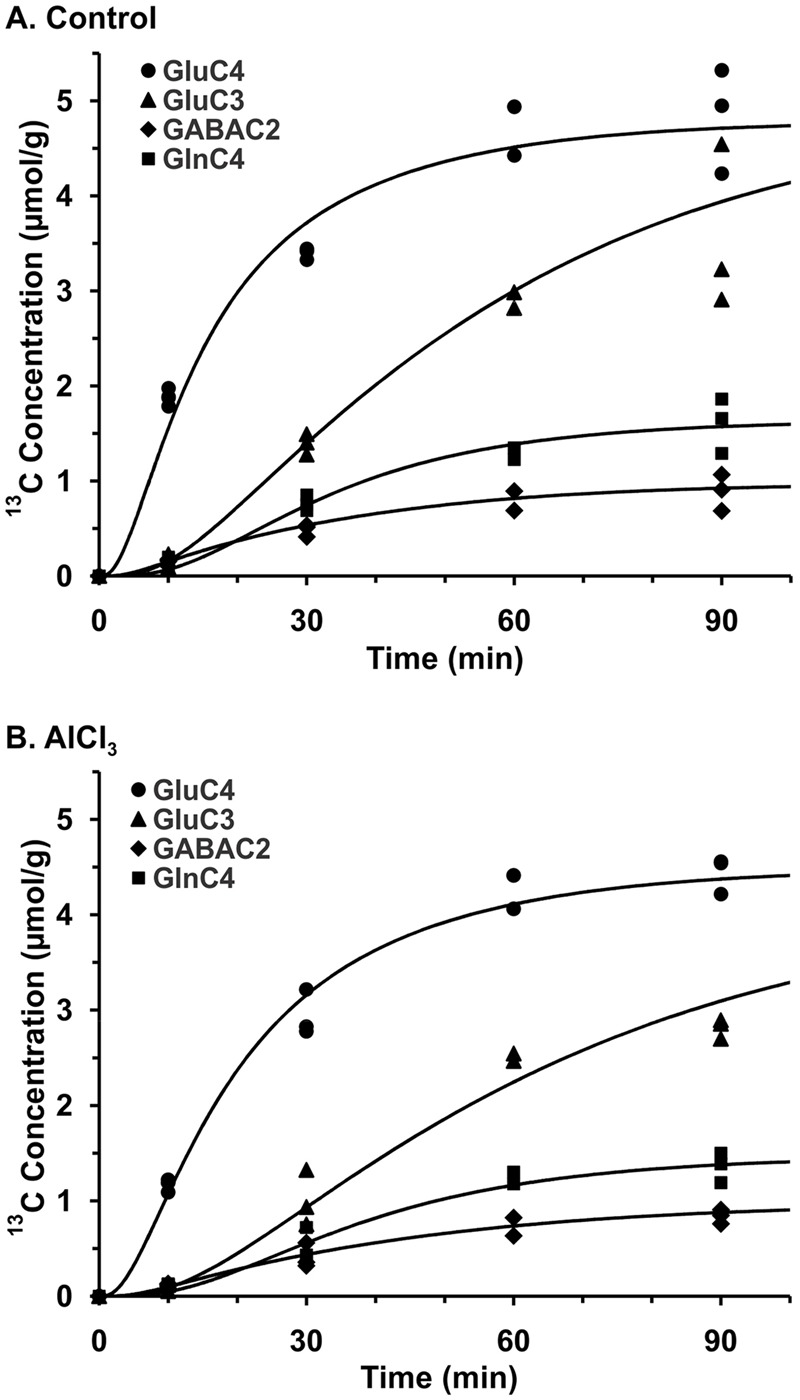
Fit of three compartment metabolic model to 13C turnover of cortical amino acids in (A) Control, (B) AlCl3 treated mice. Mice were infused with [1,6-13C2]glucose for pre-defined time. 13C Concentrations of cortical amino acids were measured in extracts in 1H-[13C]-NMR spectra. Symbols represent the measured 13C labeling, while lines show the best fit of the three compartment metabolic model.